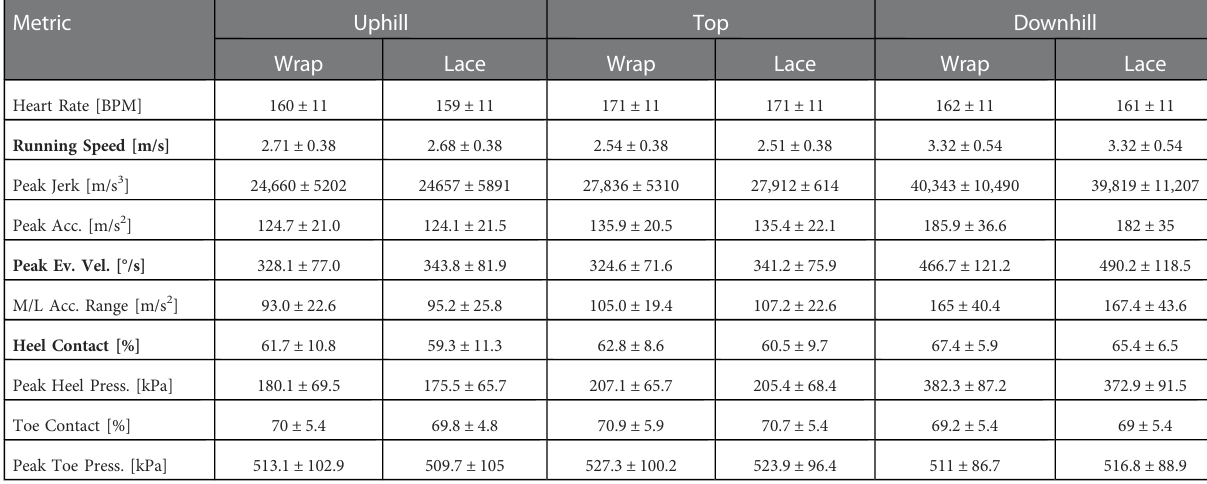
TABLE 2 Biomechanical metrics examined during the trail running loop. The bolded metrics indicate that there were signi fi cant differences between the Wrap and the Lace for each of the different trail sections. Presented are study means±standard deviations ( N =29). Metric Uphill Top Downhill Wrap Lace Wrap Lace Wrap